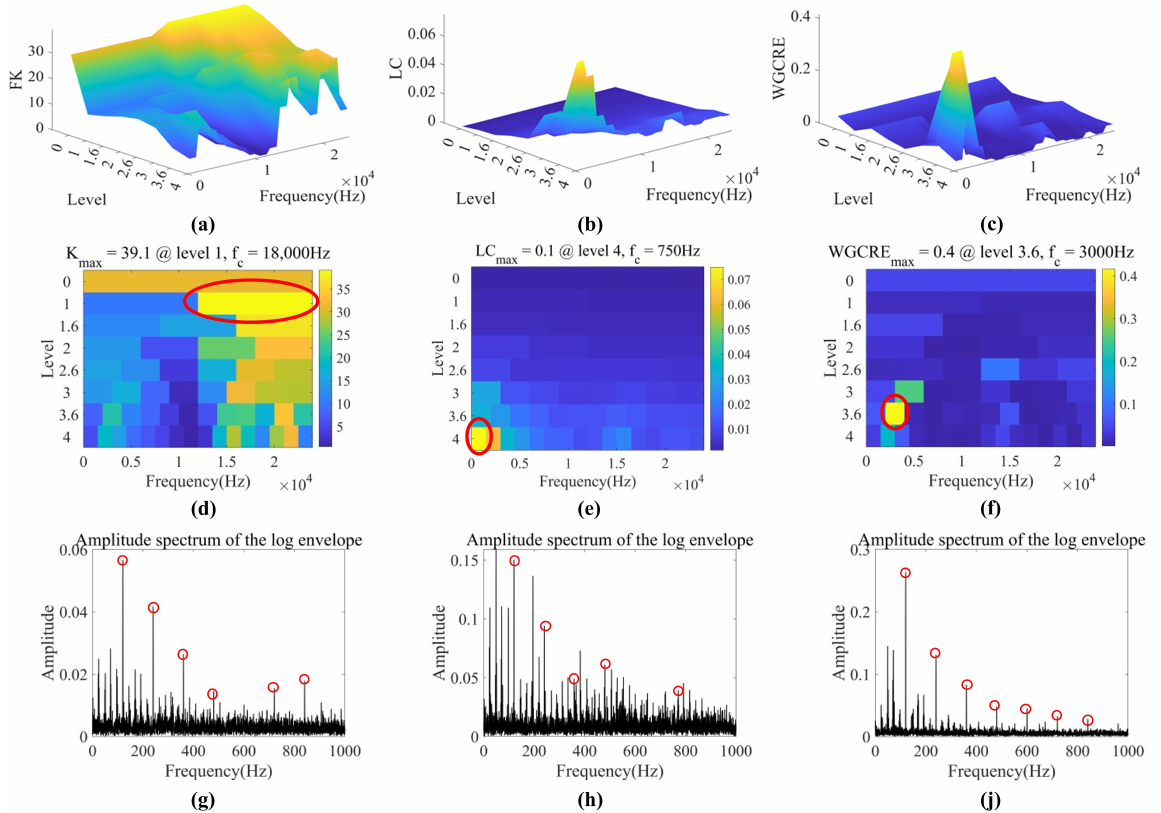
Figure 15. Optimal bands extraction of Case 4 (inner race fault). ( a – f ) are 3D and 2D FK, LC , and WGCRE –gram, respectively (optimal bands are circled in red). ( g , h , j ) are LES of FK, LC , and WGCRE , respectively (BPFIs with harmonics are marked with red circles).